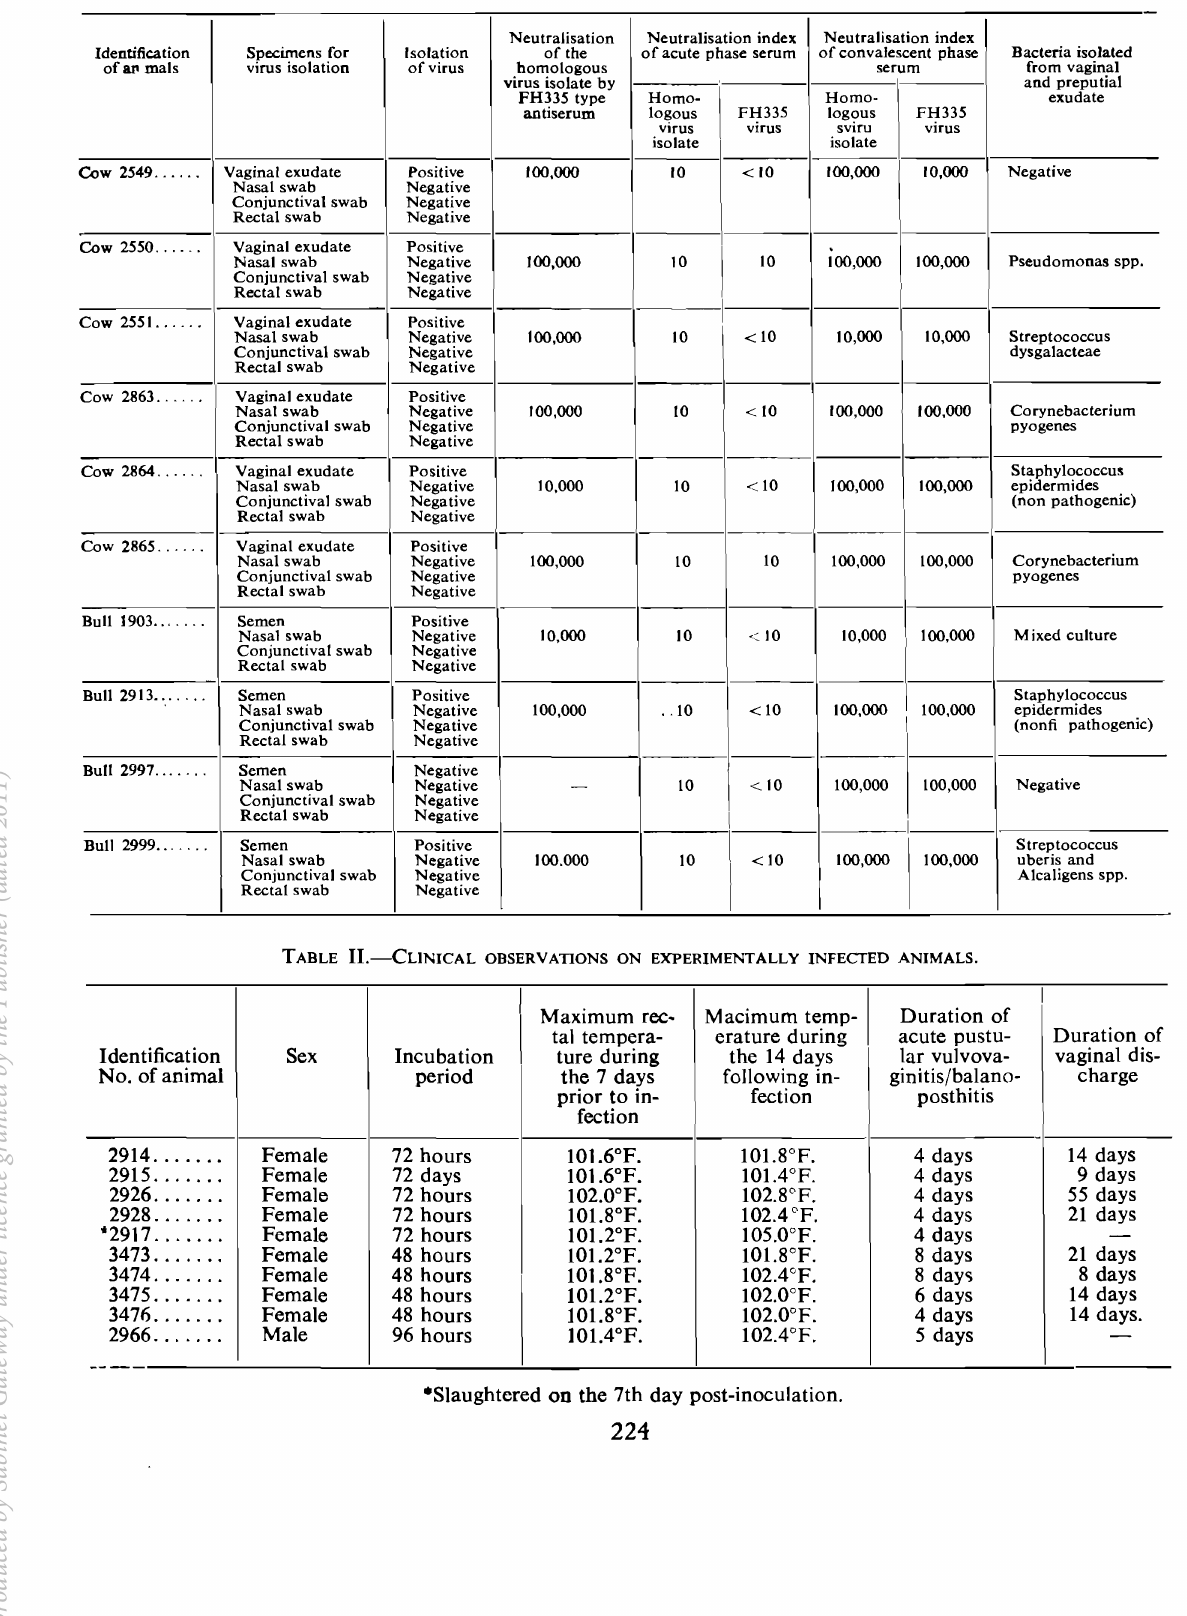
TABLE I.-RESULTS OF LABORATORY EXAMINATION OF SPECIMENS FROM NATURALLY INFECTED ANIMALS.